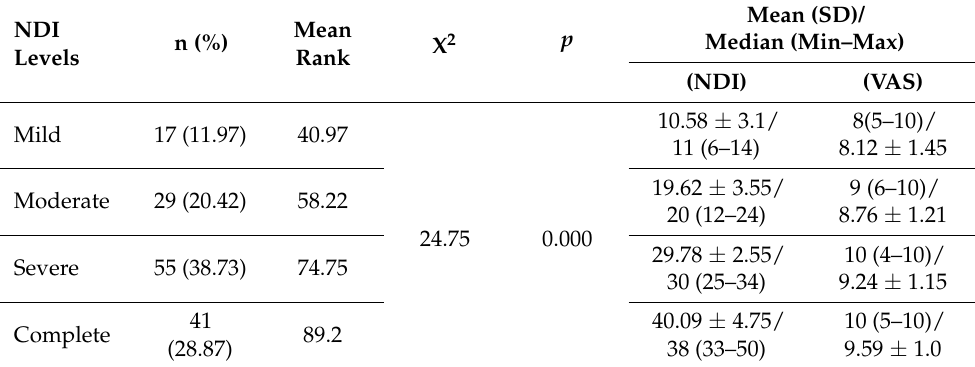
Table 2. The Kruskal–Wallis Test Results and The Headache Intensity and Disability Scores According to Neck Disability Levels.